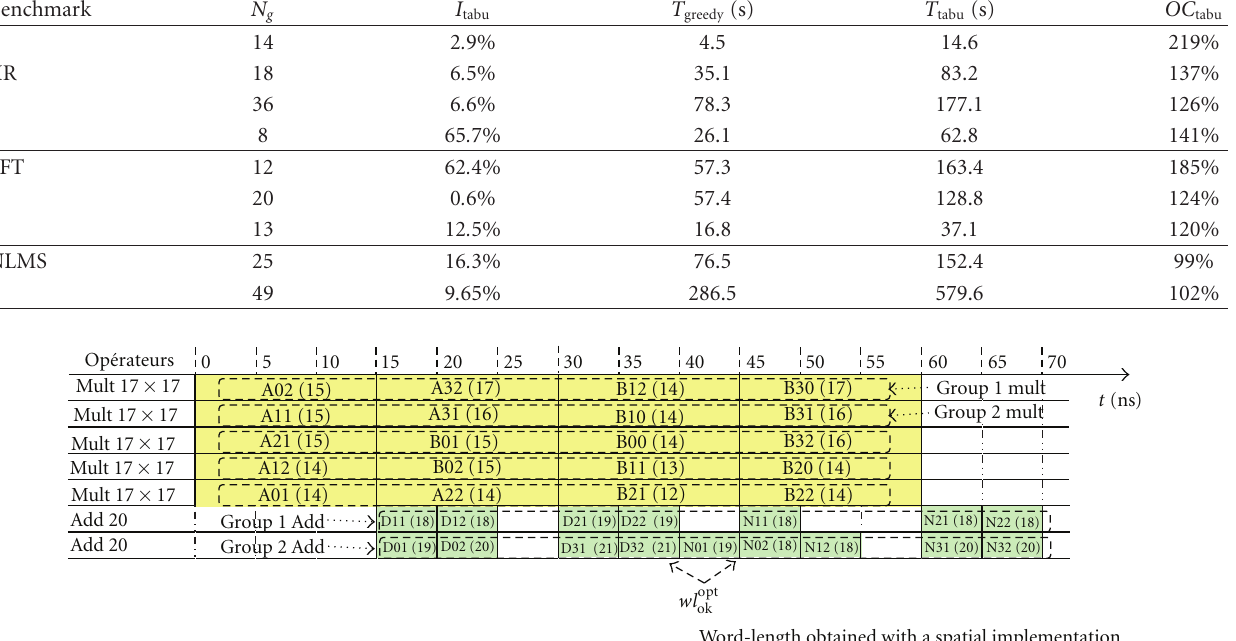
Table 2: Comparison of the tabu search and greedy algorithms in terms of quality improvement I tabu and execution time over-cost ( OC tabu )